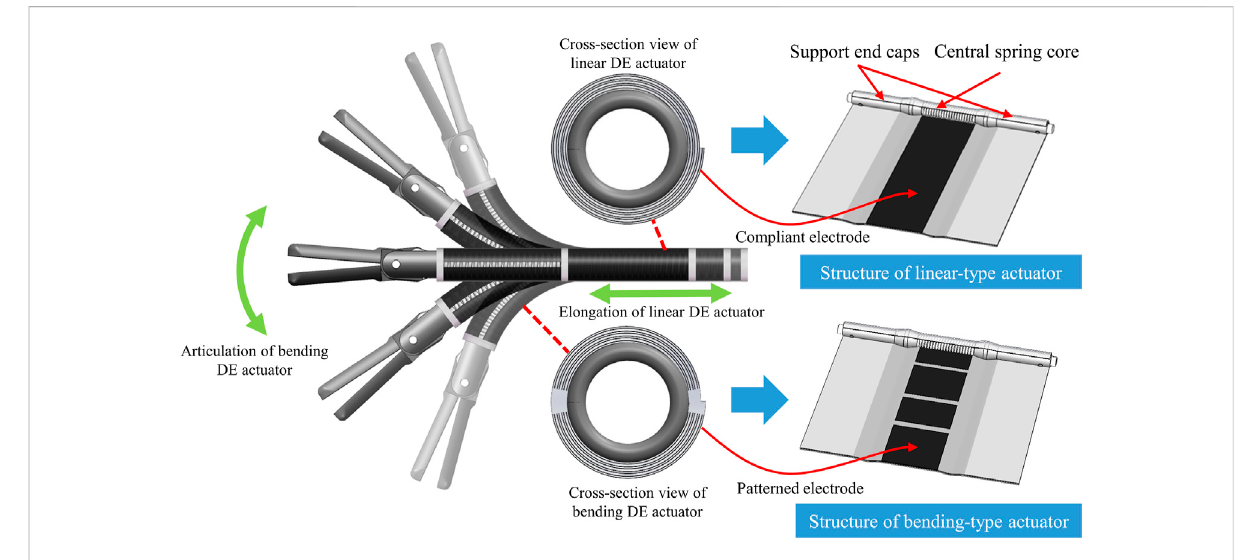
FIGURE 1 Design concept of linear- and bending-type DE actuators for MIS